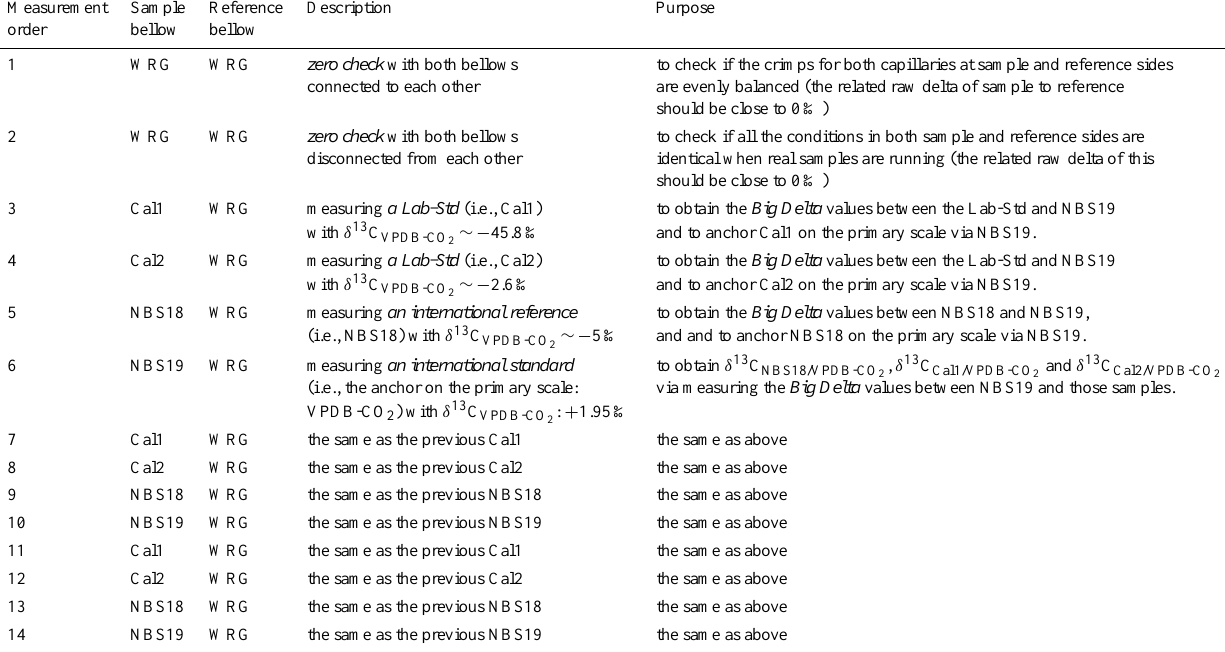
Table A1. Annual calibration sequence by IRMS